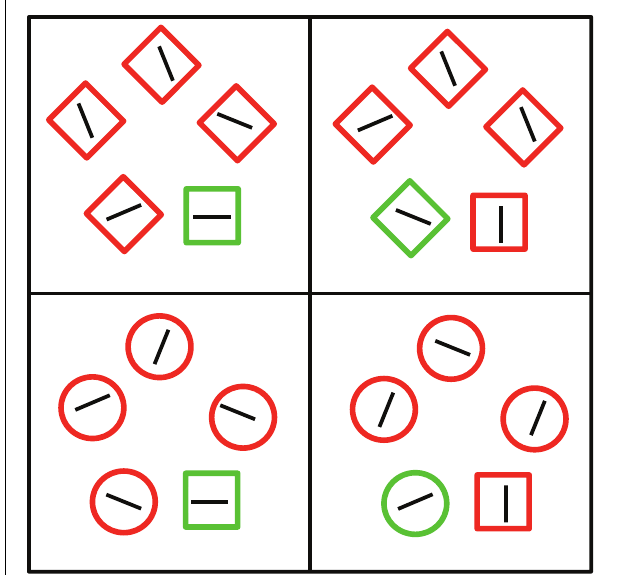
FIGURE 3 | Examples of the four trial types present in Experiment 2. Participants were always instructed to search for the unique square in the display. The left side depicts congruent trials, in which the target shape was also a color singleton. The right side depicts incongruent trials, in which one of the distractor shapes was also a color singleton. Images are not to